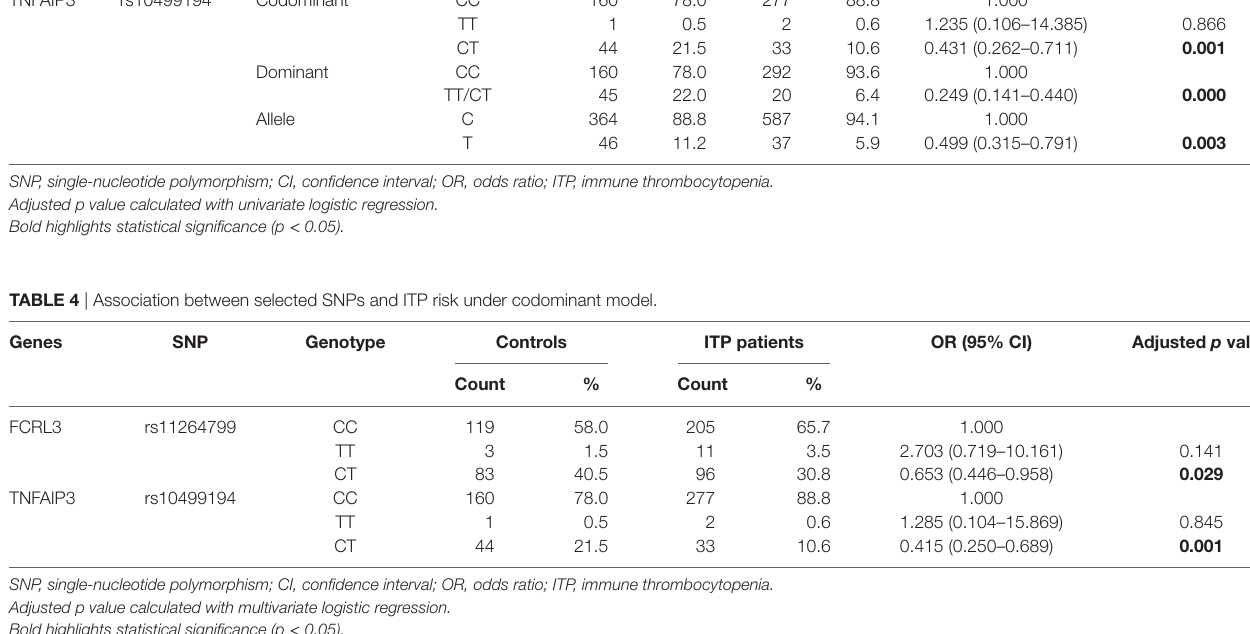
SNP, single-nucleotide polymorphism; CI, confidence interval; OR, odds ratio; ITP, immune thrombocytopenia. Adjusted p value calculated with multivariate logistic regression. Bold highlights statistical significance (p < 0.05).